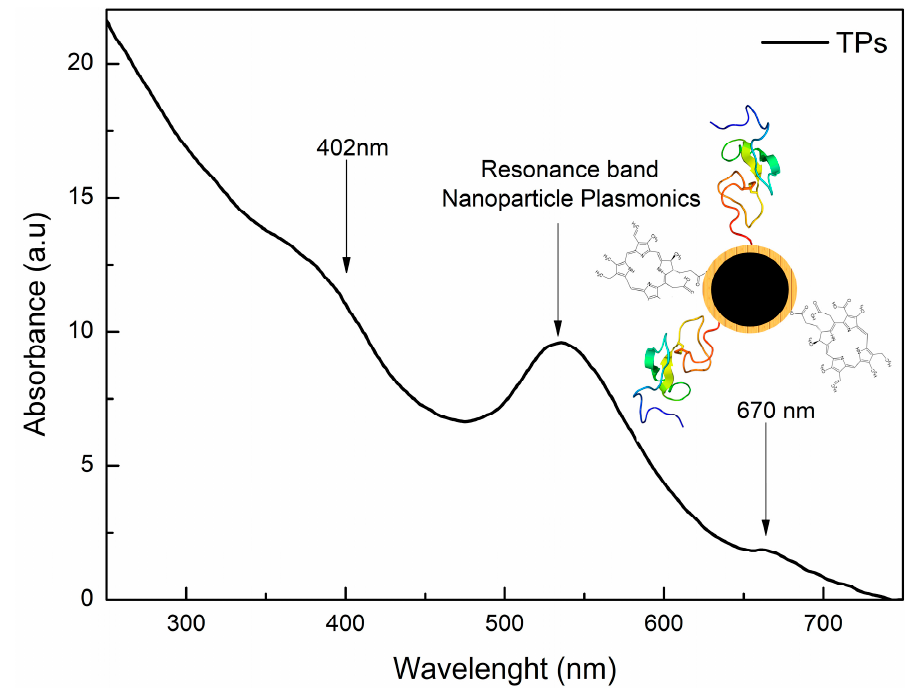
Figure 4. UV-visible spectrum of TPs and schematic representation.